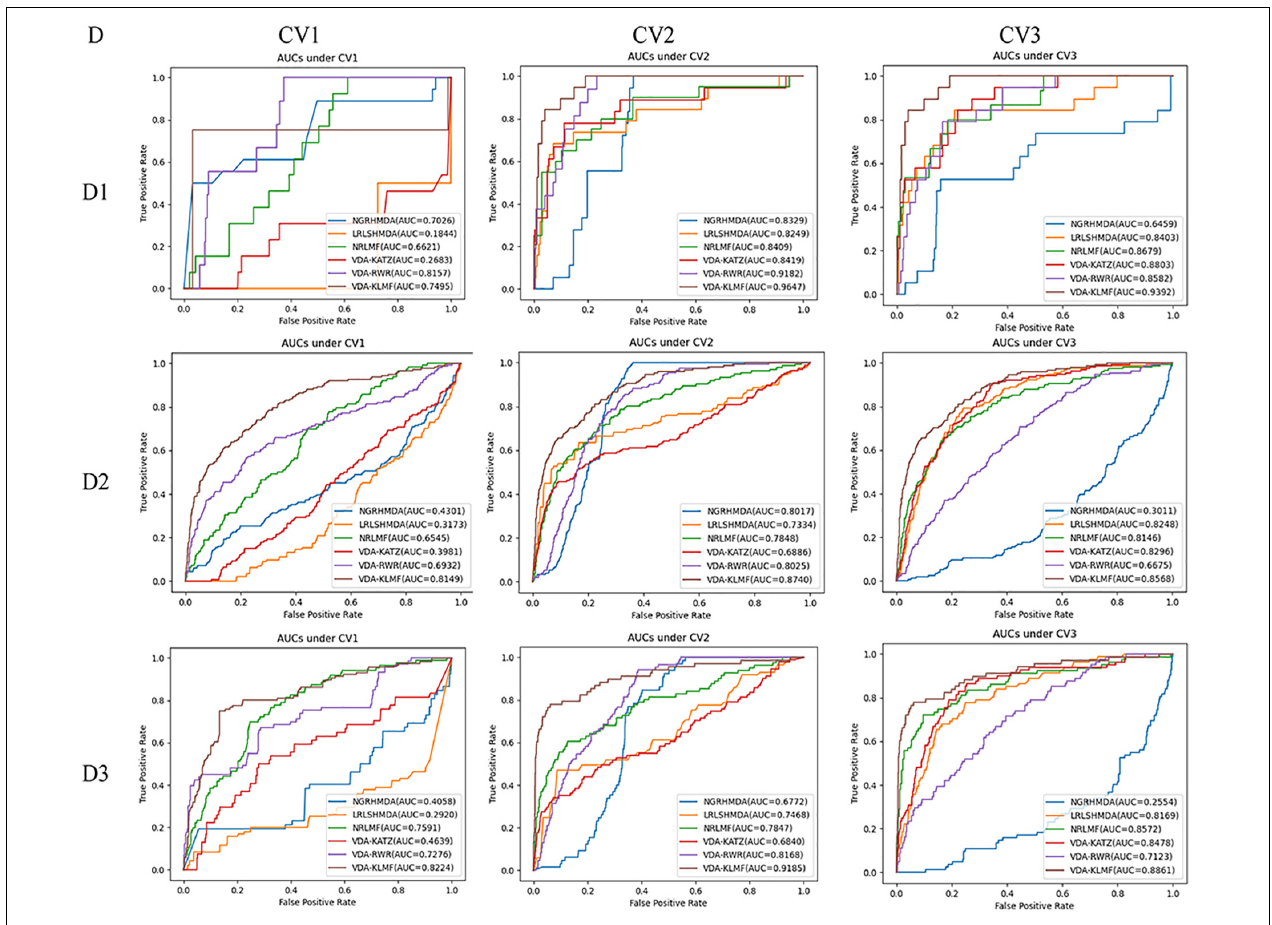
FIGURE 2 | The AUC values predicted by six VDA prediction methods (D denotes dataset, Dl denotes dataset 1, D2 denotes dataset 2, D3 denotes dataset 3).